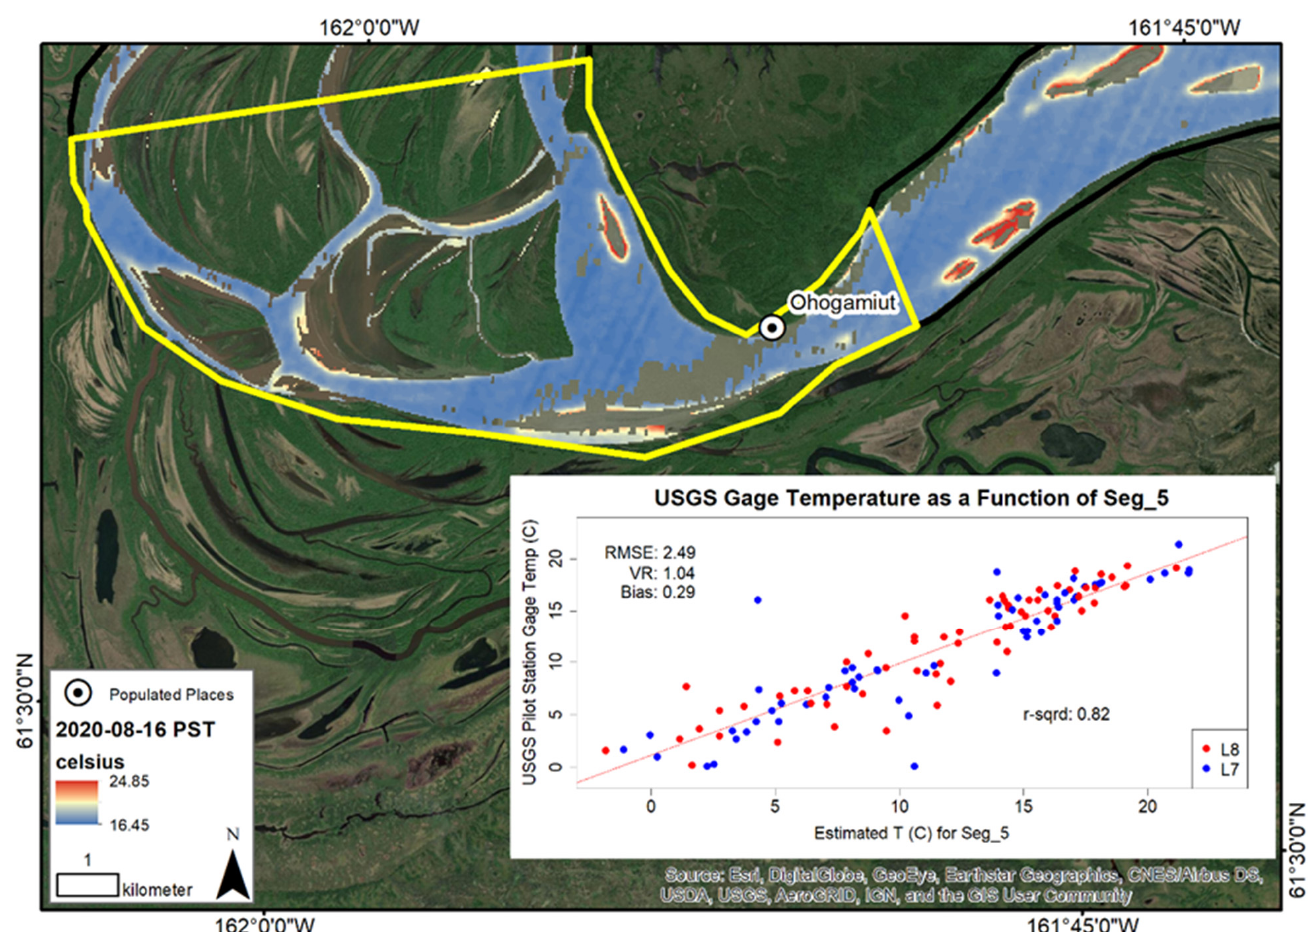
Figure A3. Segment 5 captures the first large bend in the Yukon River after it enters the ARD tile and rounds the southwest terminus of the Ilivit Mountains. The river bends to the north and splits into numerous channels as it bisects Willow Island, Blade Island, and Blue Fish Island. Willow Island, the large upstream island visible in the scene, is prone to partial inundation during high water stages. With the addition of multiple channels and large islands, the ratio of surface water to shoreline decreases. This allows for estimates of water temperature to be more significantly influenced by warmer nearshore water. However, correlation with corresponding temperature measurements remains good (RMSE = 2.49 °C, r 2 = 0.82) and suggests that the majority of the Landsat passes capture enough open water to provide a reasonable estimate that is not significantly influenced by nearshore warm water. A NoData gap is also present at the apex of the meander.